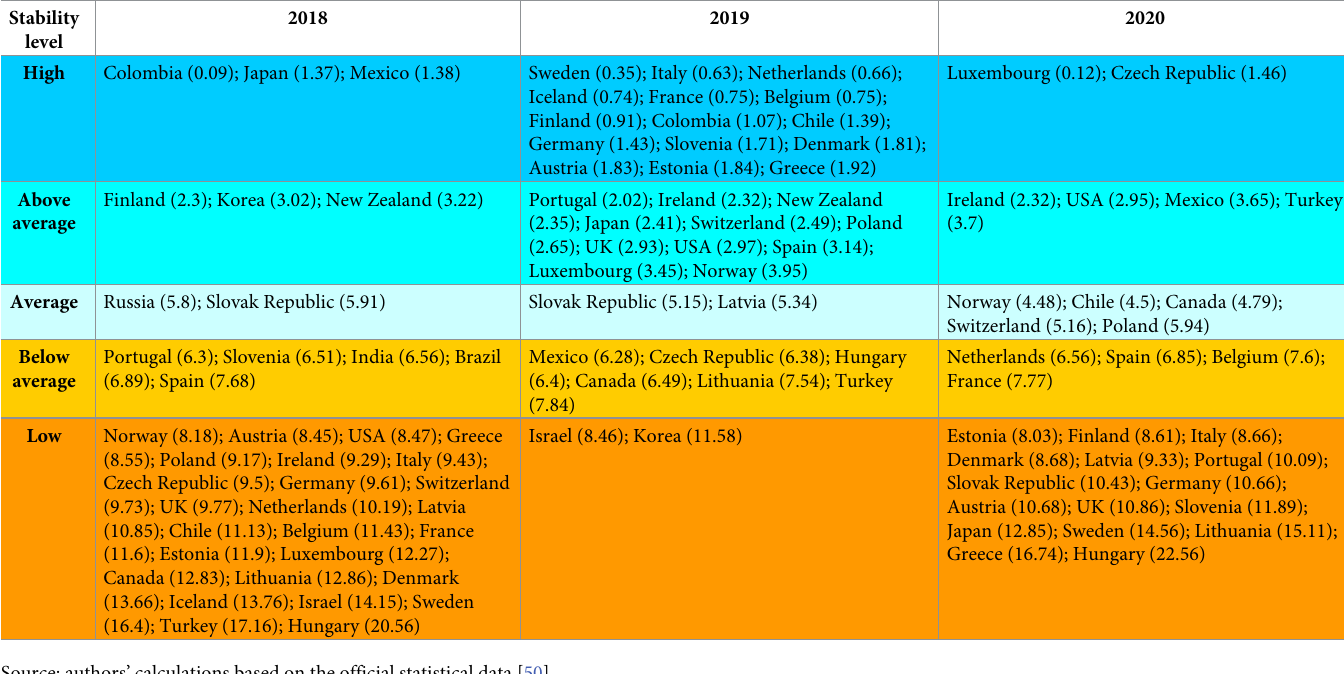
Table 3. Stability levels of financial development of OECD+ countries in 2018–2020, US$ thousands. Stability